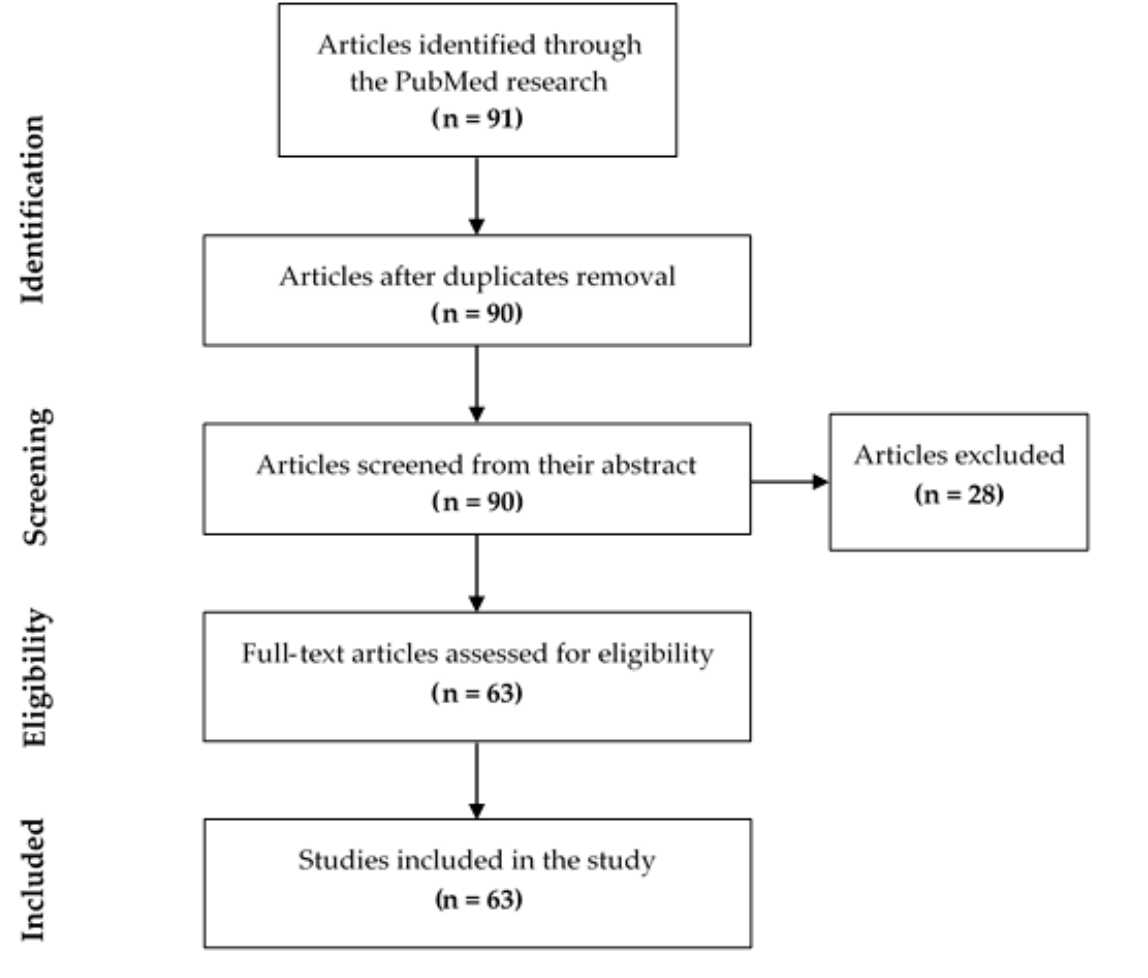
Figure 2. Flow diagram of study